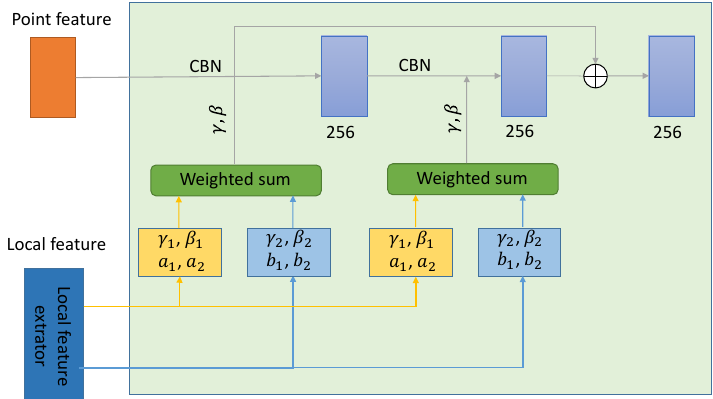
Figure 5. Decoder network architecture.